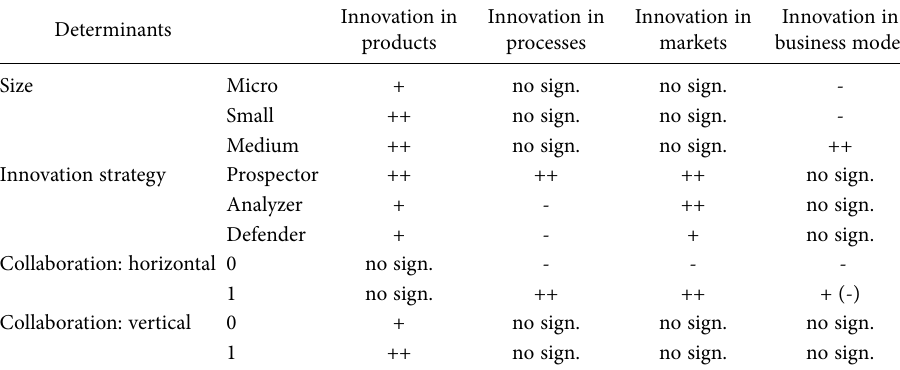
Table 5. Determinant comparison for types of innovation Determinants